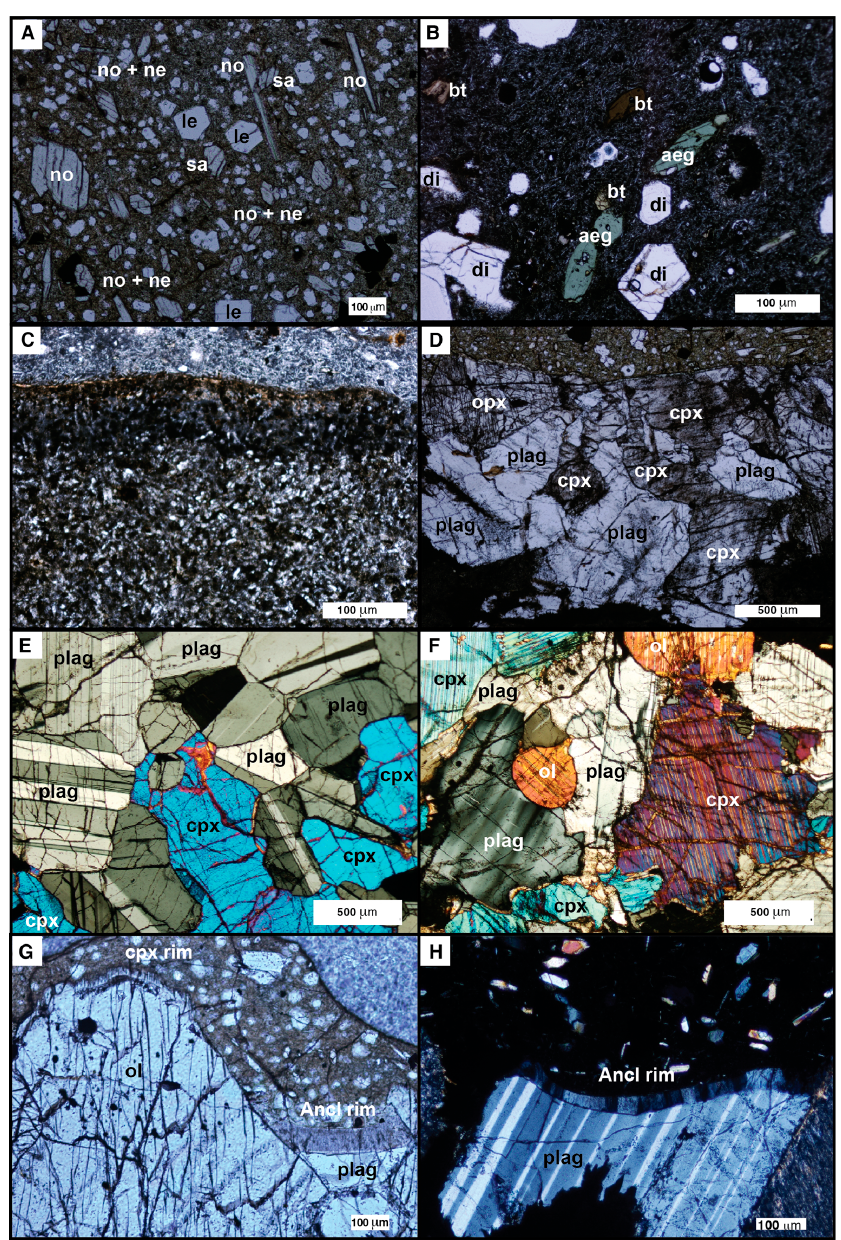
Figure 2. Photomicrographs of host lavas and xenoliths from Cape